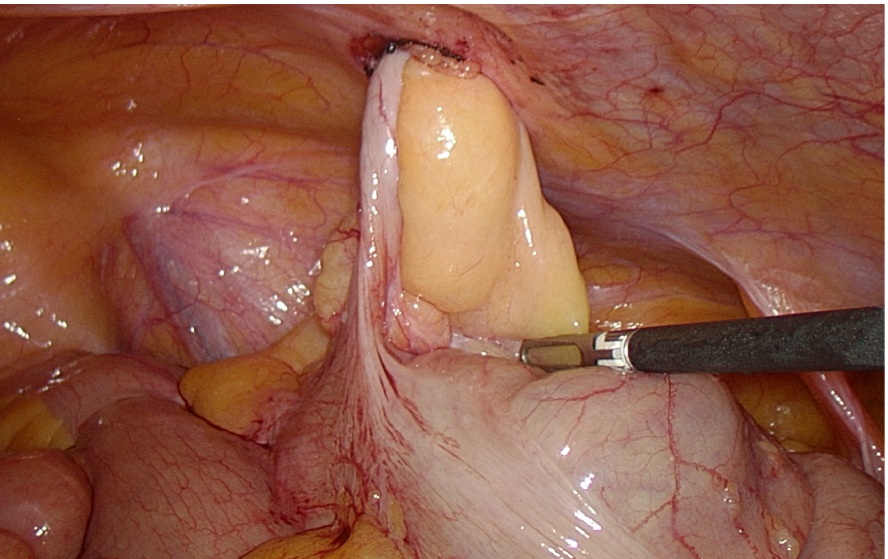
Figure 2. Vermiform appendix together with the mesentery within the previous trocar incision in the right iliac region.